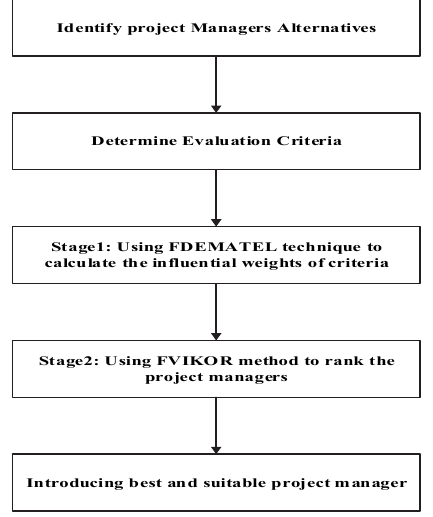
Fig. 1. Flowchart of the proposed hybrid MCDM